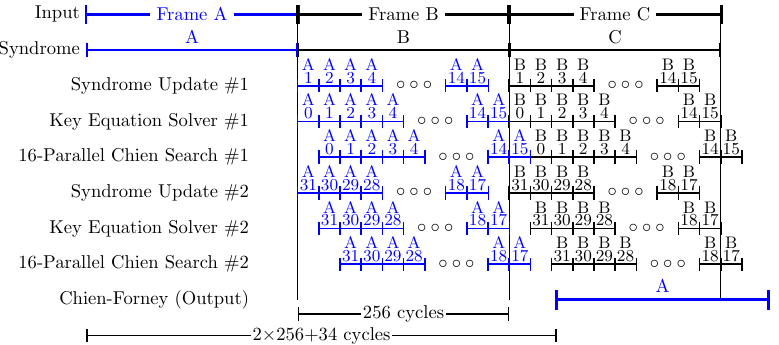
Figure 3. Decoding chronogram for the Q5